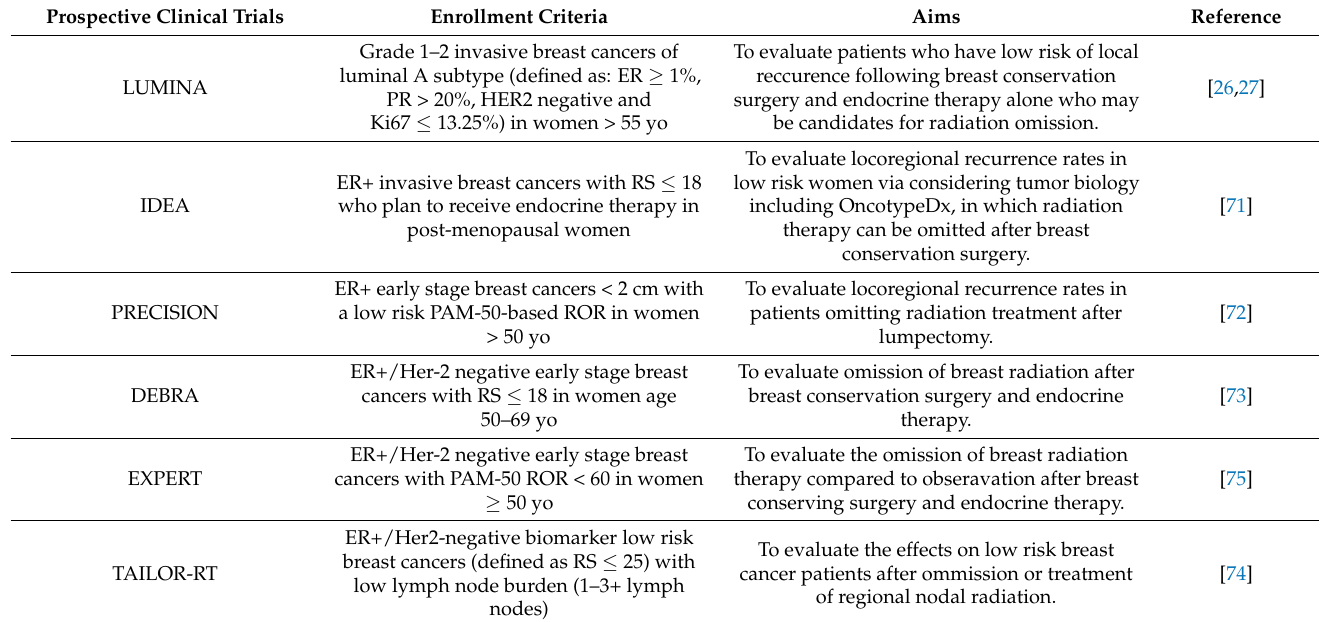
Table 2. Current prospective clinical trials evaluating whether prognostic gene assays can identify low risk ER+ early breast cancer patients in which radiation therapy can be safely